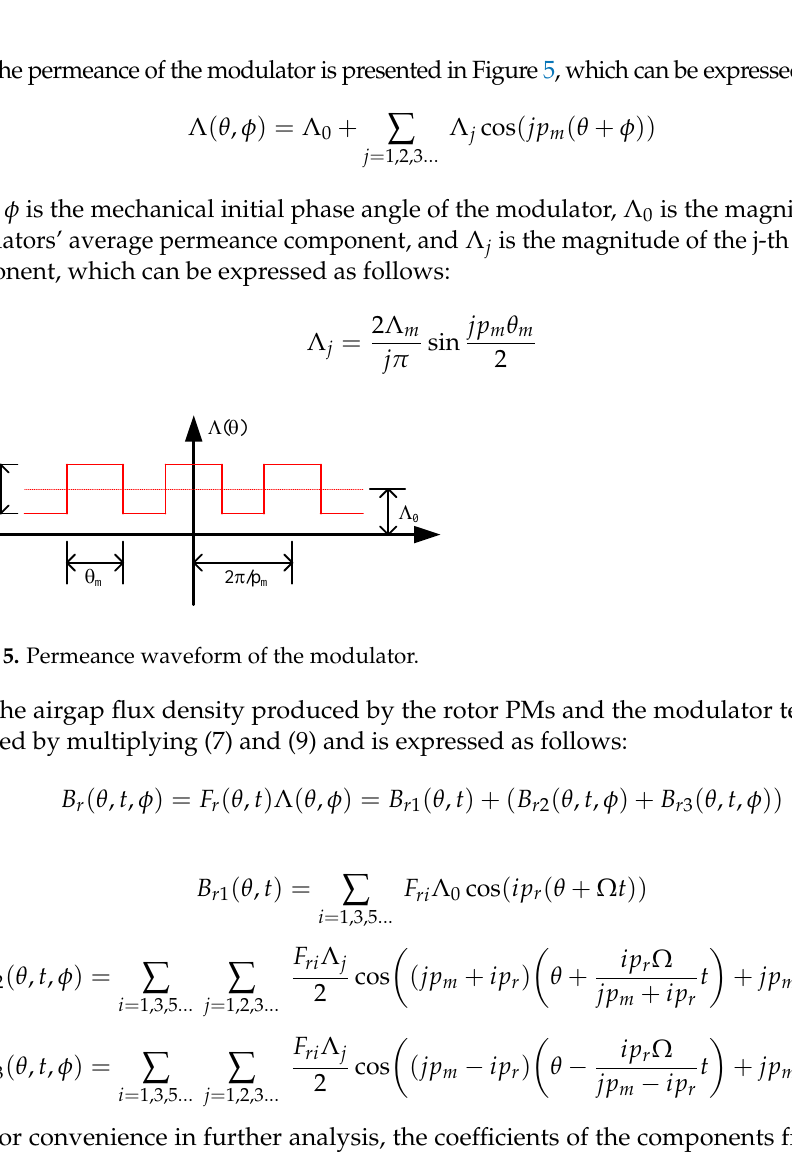
Figure 4. MMF waveform of the rotor PMs.